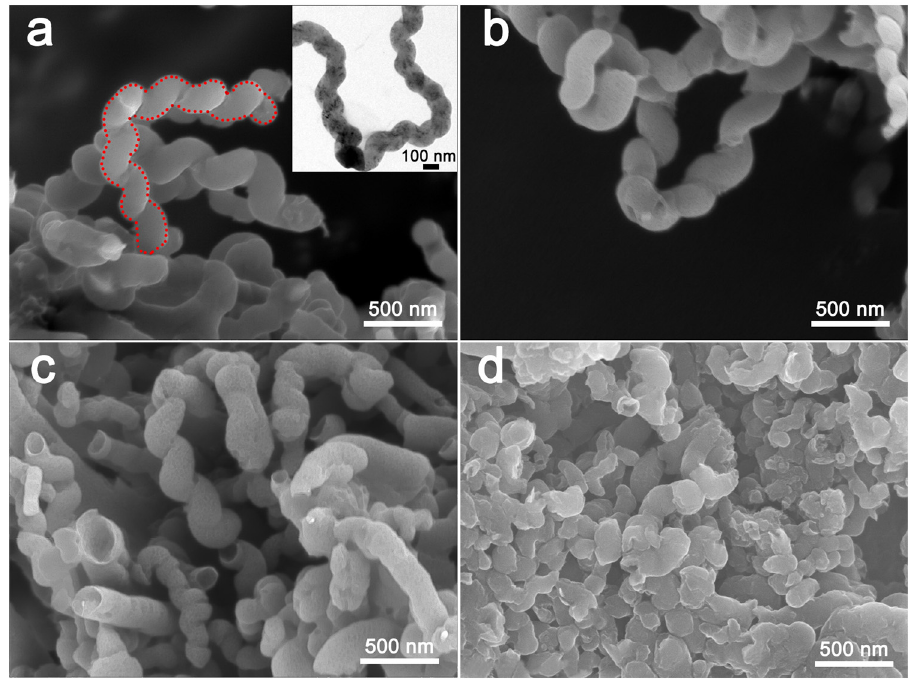
Figure 1: Morphological analysis of HCNTs. The SEM images of ( a ) O - HCNTs and ( b – d ) F - HCNTs treated for 0.5, 1, and 3 h.